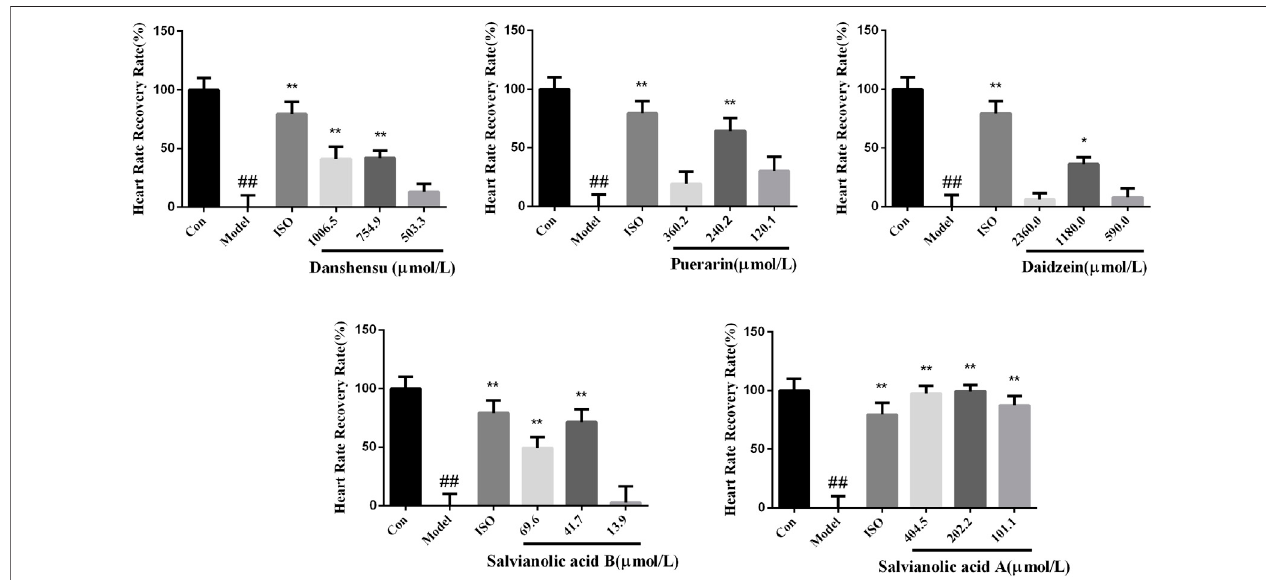
FIGURE8| Heartraterecoveryrateofzebra fi shlarvaetreatedwithcompounds. n =12. # p < 0.05vs.control, ## p < 0.01vs.control,* p < 0.05vs.model, and** p < 0.01 vs.